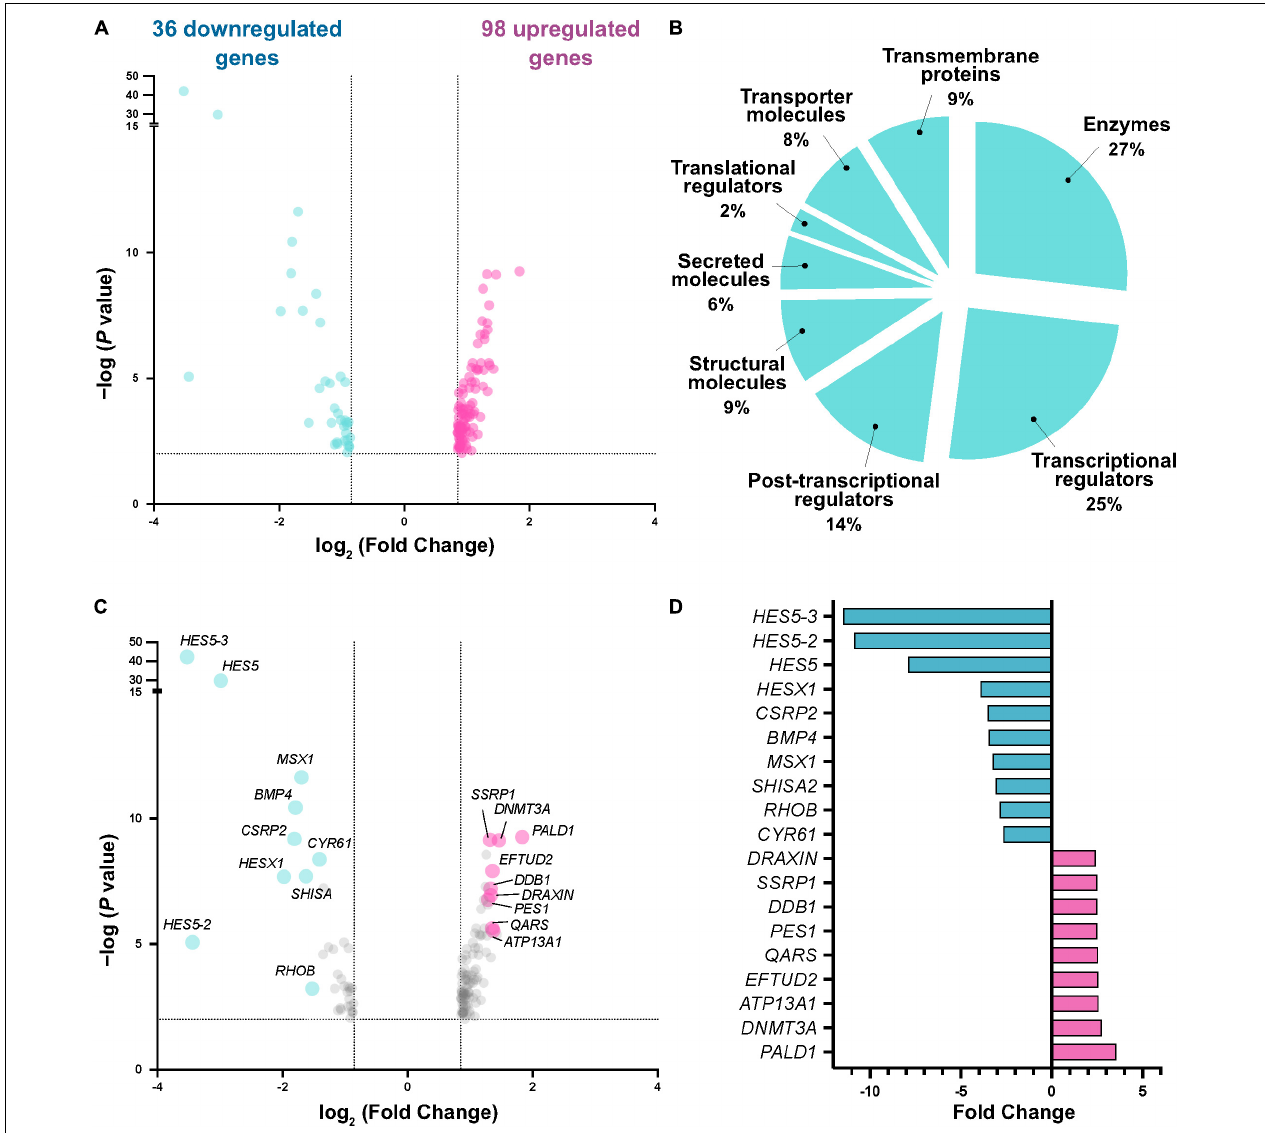
FIGURE 2 | Transcriptome analysis reveals differentially expressed genes responsive to Draxin-mediated canonical Wnt inhibition. (A) Volcano plot following differential expression analysis and filtering. Dotted lines indicate significance and fold change cutoffs for downstream analysis. (B) Molecular functions for the 134 differentially expressed genes. (C,D) Most enriched and depleted genes in cranial neural crest with Draxin